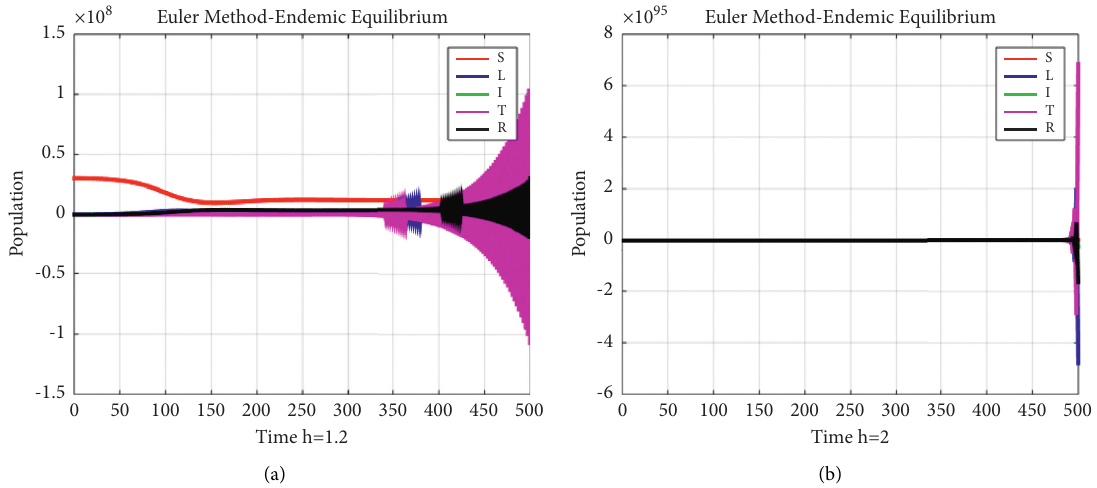
Figure 2: Simulations of forward Euler at endemic equilibrium for step size h � 1 . 2 and h � 2 (a) Simulations of forward Euler. (b) Simulations of forward